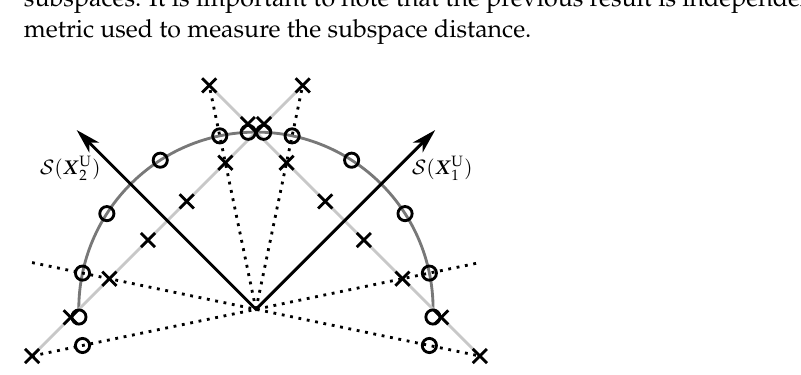
Figure 6. Two-dimensional graphical representation of the potential consequence of a wrong power distribution between the pilot matrix and the coherent code. Four pairs of constellation elements span the same subspaces, which are drawn with dotted lines. (element: ‘ ◦ ’ symbols, coherent code: ‘ × ’